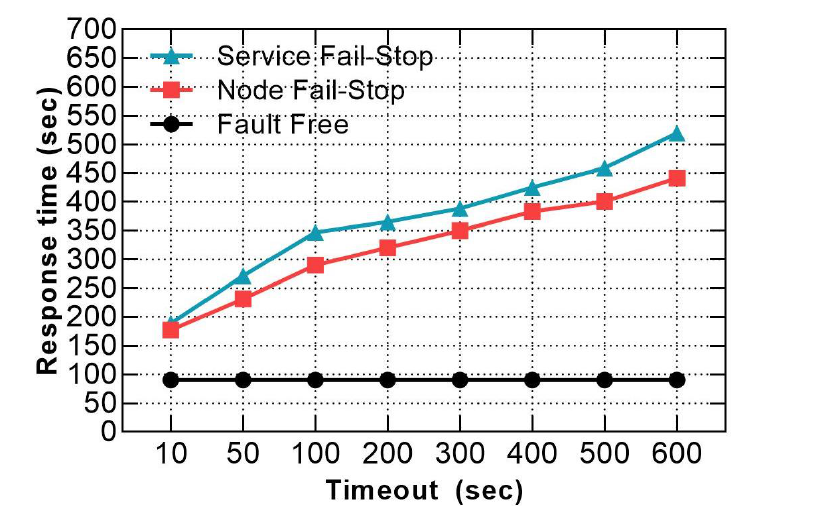
Figure 8. Comparison between node fail-stop and service fail-stop response times when using various timeout